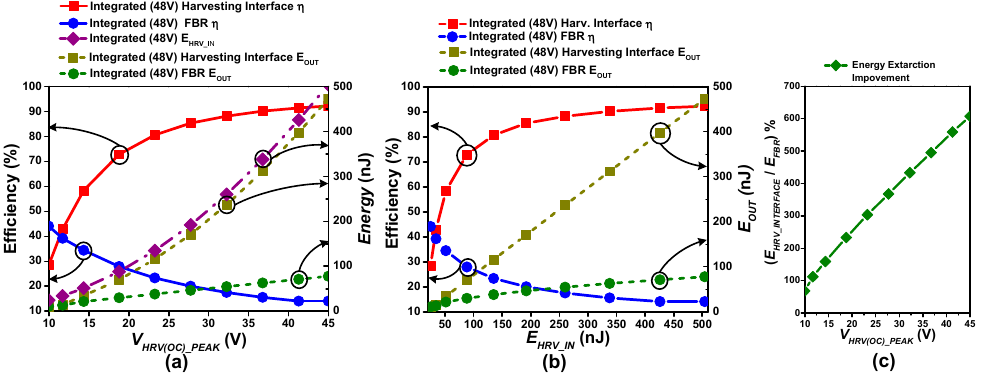
Figure 14. ( a , b ) E ffi ciency comparison between the FBR and the proposed harvesting interface with integrated power switches at harvester open circuit voltage and input energy on x-axis respectively when harvesting from a flexible piezoelectric harvester source (C P = 500 pF) under irregular excitation at 3.3 V battery charging, ( c ) Energy extraction improvement w.r.t FBR.